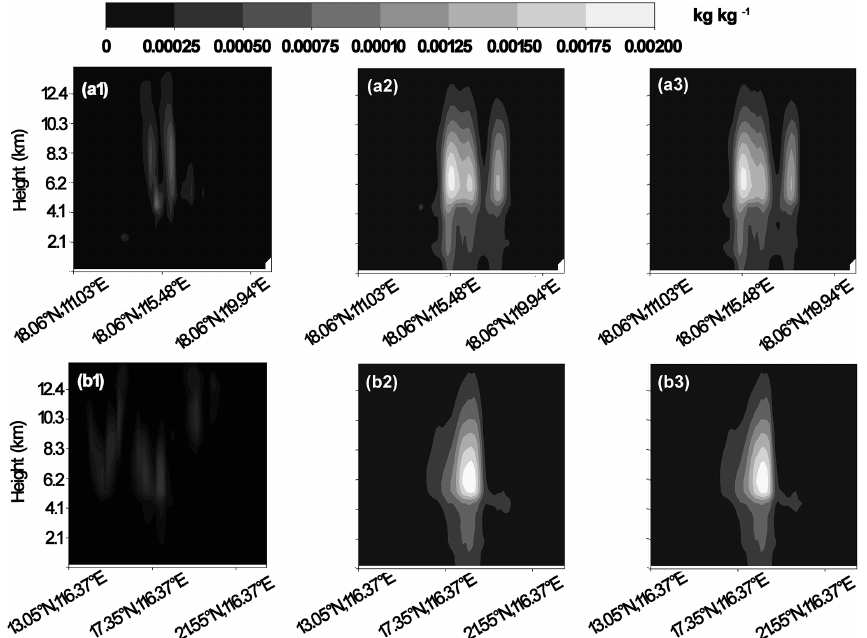
Figure 8. The cross section of the liquid and ice water mixing ratio of Exp-01 at 02:00UTC, 18 August 2020 for the AB (a1–a3) and CD (b1–b3) lines shown in Fig. 1. The panels correspond to the nature run (a1, b1) , the ensemble mean of the first guess (a2, b2) , and the ensemble mean of the analysis (a3, b3) .